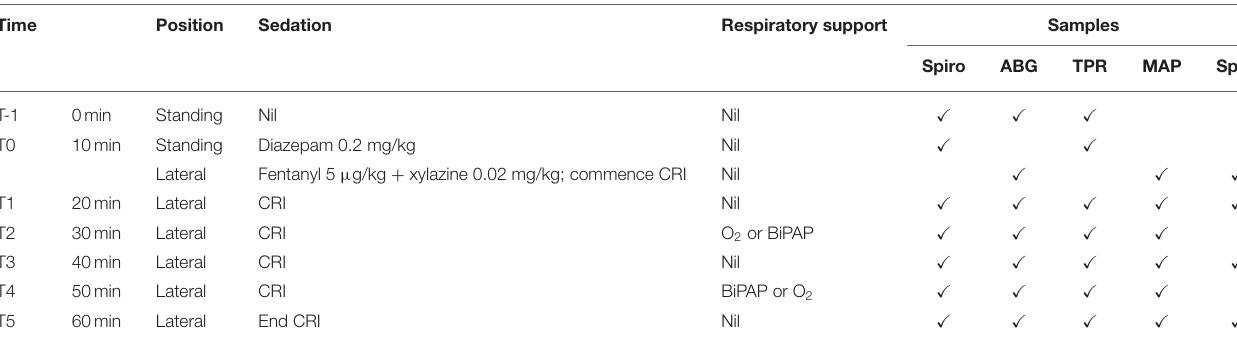
TABLE 1 | Treatment and sampling